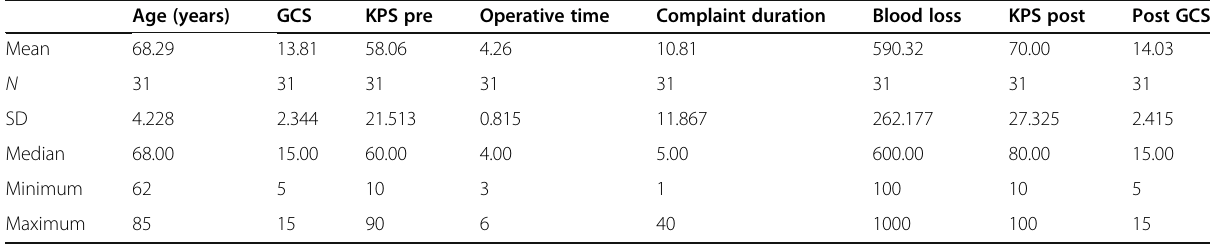
Table 1 The age, operative data, and the perioperative GCS and KPS